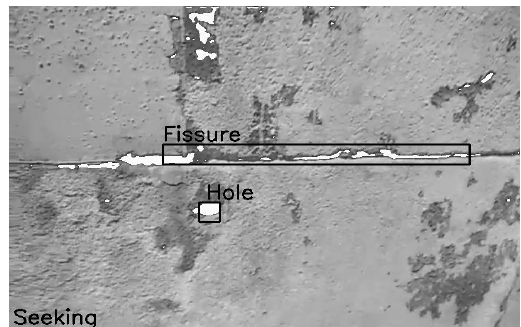
Figure 5. Example of original versus resulting image after flaw separation.